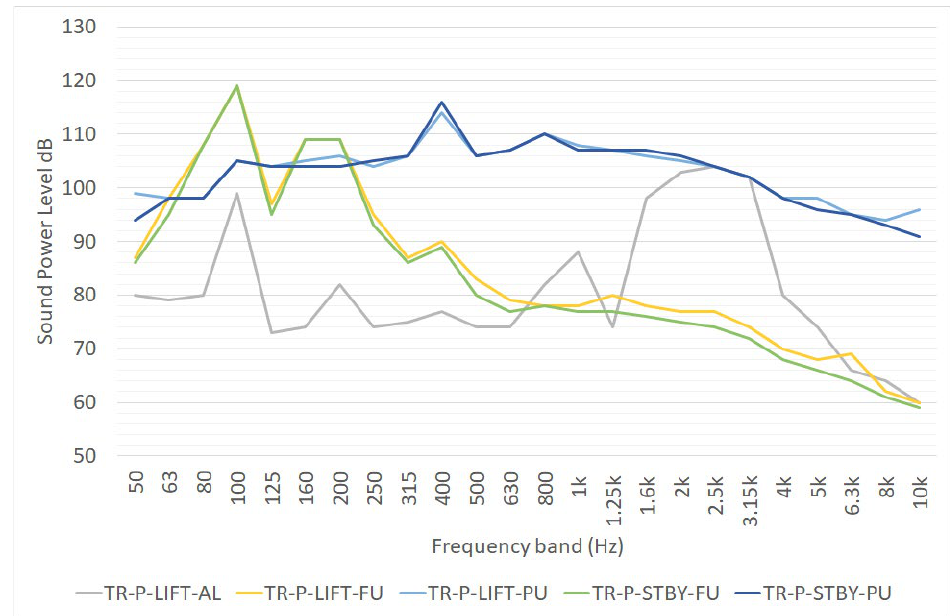
Figure 2. One-third octave sound power level spectra of a transtainer, as reported in